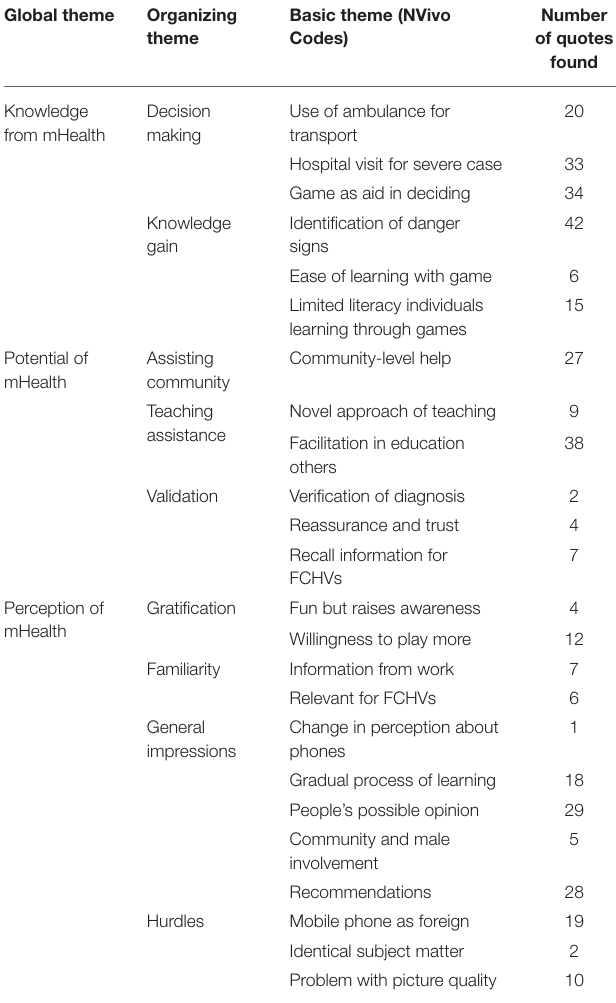
TABLE 2 | Themes derived from the data. Global theme Organizing